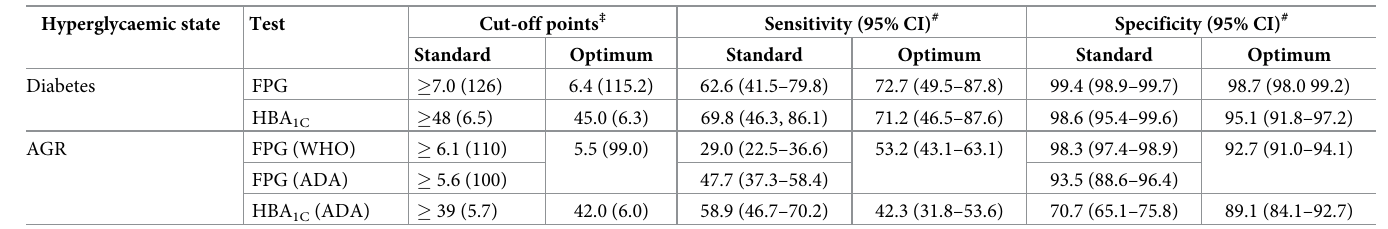
Table 3. Sensitivity and specificity at standard and optimum cut-off